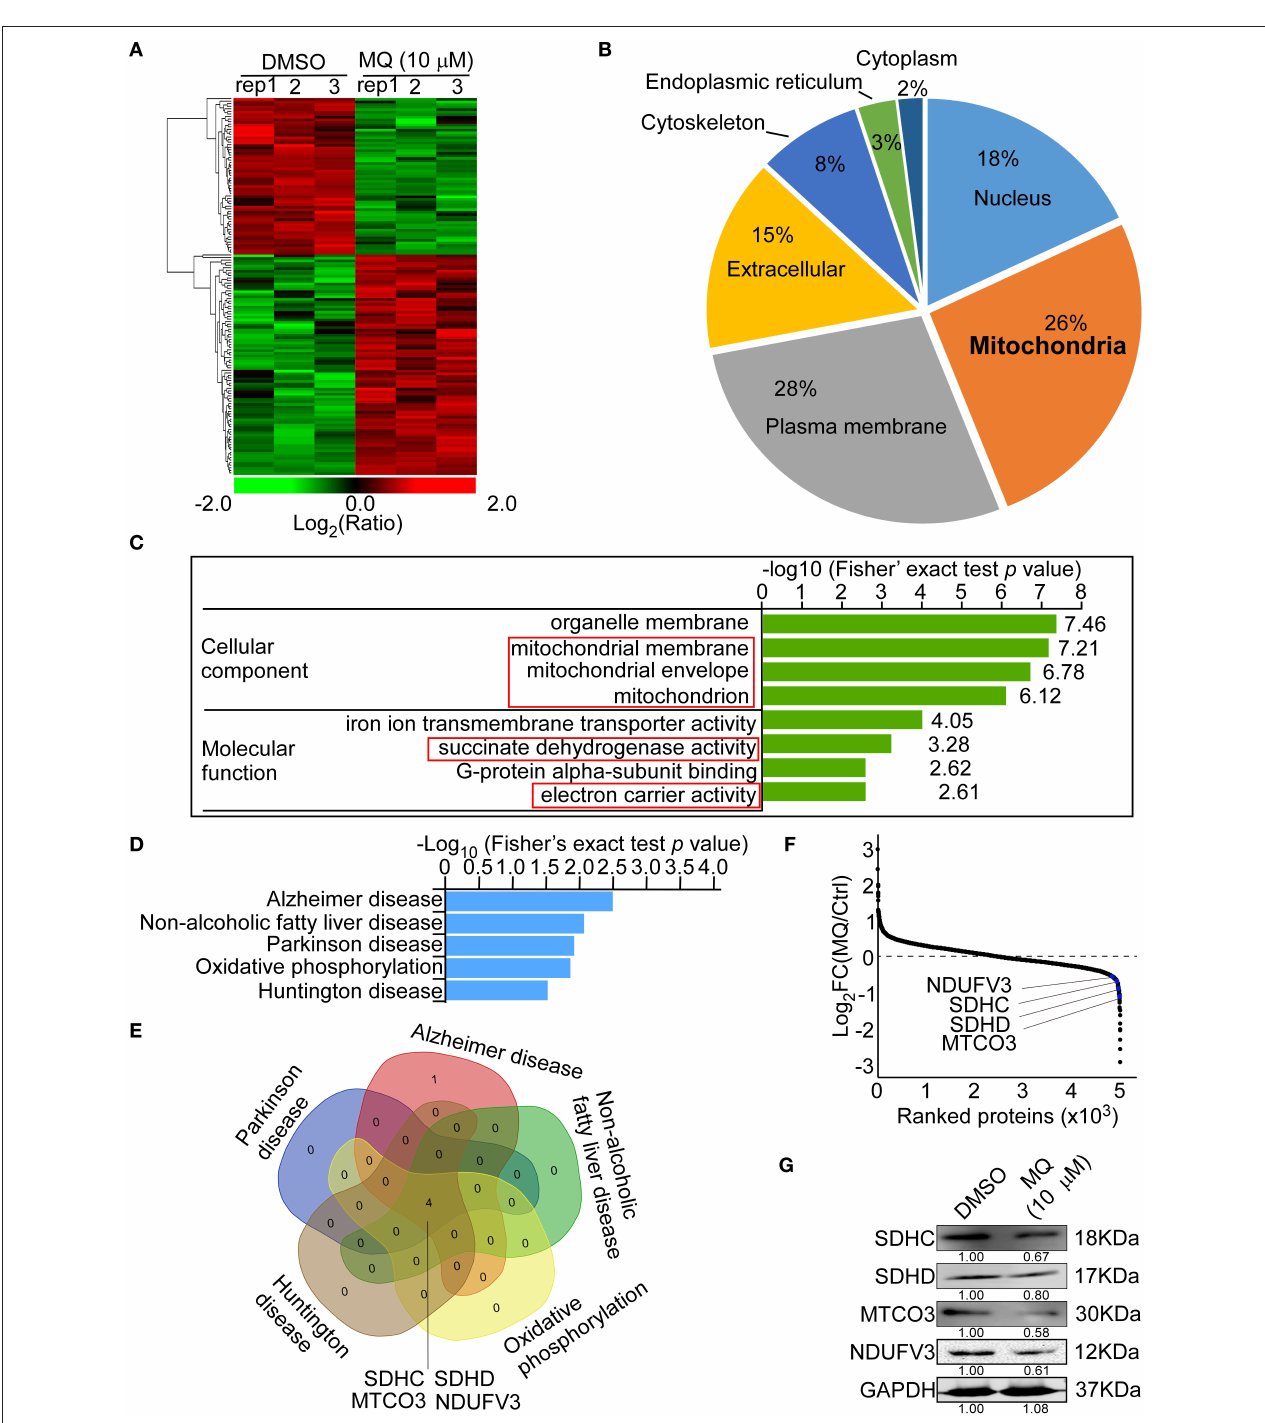
FIGURE 3 | Mefloquine remodels proteome of KYSE150 cells. MS analysis of global protein changes in KYSE150 cells after MQ (10 µ M) treatment for 24h compared with DMSO treatment. (A) Heat map representation of differentially expressed proteins between DMSO and MQ (10 µ M) groups. The color key shows the log2 transformed protein amount ratios; (B) WoLF PSORT software analysis of the sub-cellular localization of differentially changed proteins; (C) Gene ontology term enrichment classification of differentially changed proteins according to cellular component and molecular function, with the top 4 related components and functions shown; (D) KEGG pathway enrichment map of down-regulated pathways (blue bars). Data was shown as -Log10 (Fisher’s exact test p- value); (E) Venn diagram indicating the overlap between the 5 downregulated signaling pathways. Four overlapping proteins were listed; (F) Averaged quantitative kinase data from the full proteome, ranked according to their Log2 FC between the DMSO and MQ-treated cells, and the locations of SDHC, SDHD, MTCO3, and NDUFV3 were shown; (G) Western blot for SDHC, SDHD, MTCO3, and NDUFV3 in KYSE150 cells after DMSO or MQ (10 µ M) treatment.